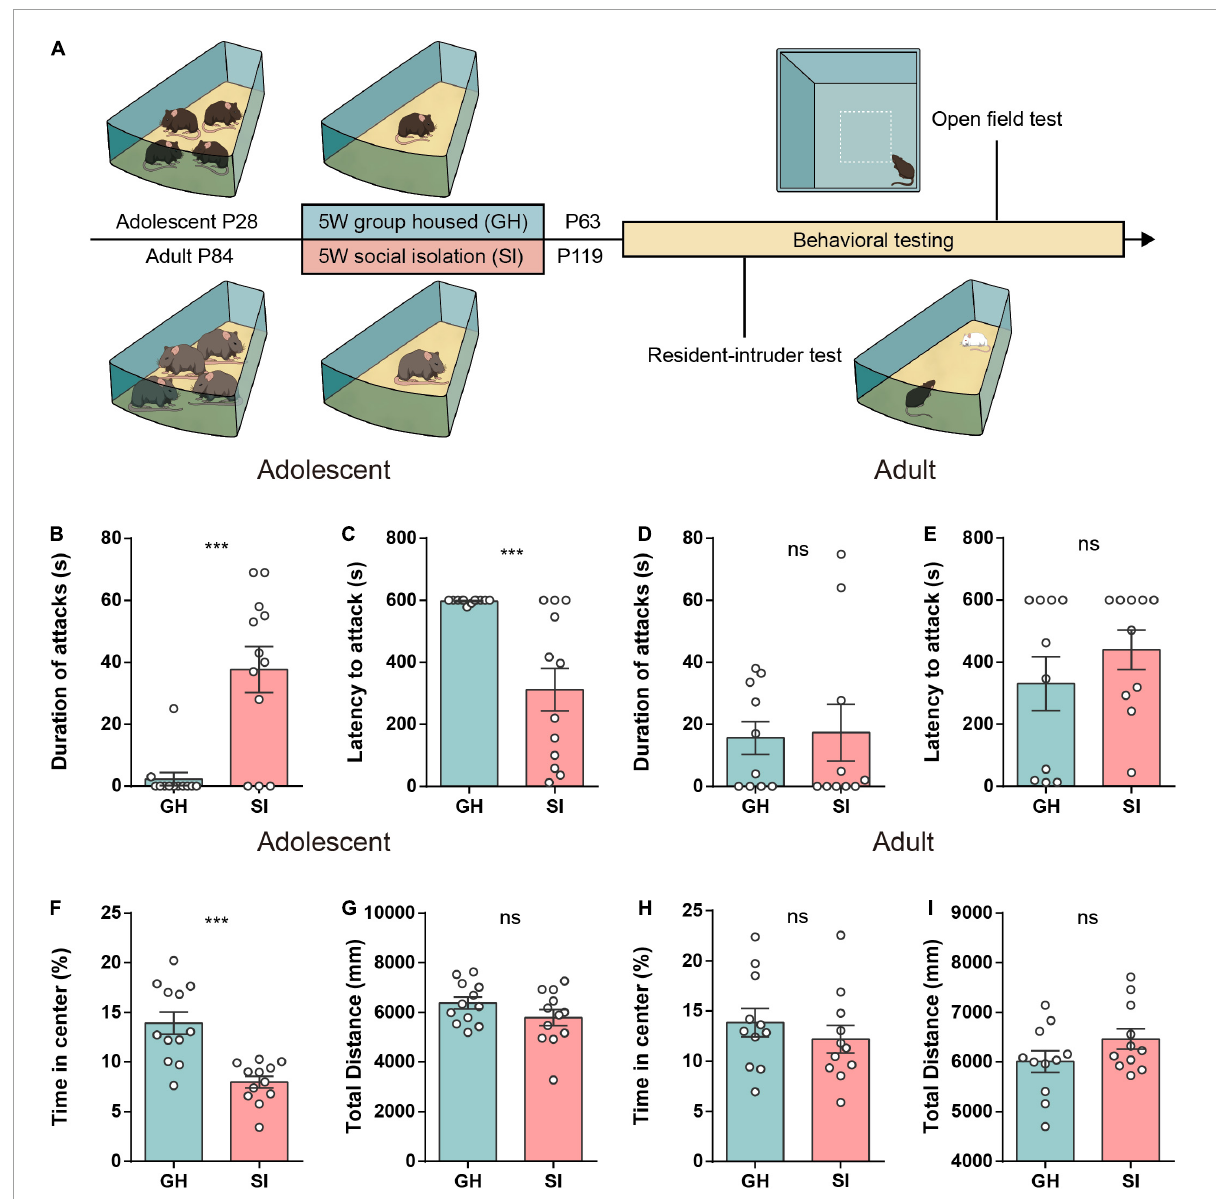
FIGURE1 Mice exposed to chronic isolation stress during adolescence but not adulthood exhibit increased aggression and anxiety-like behavior. (A) Schematic of the social isolation model used in this study. (B,C) The duration (B) and latency (C) of aggression in the RI test of group-housed and socially isolated adolescent mice ( n = 12 mice/group, duration of attack: GH, 2.33 ± 2.08, SI, 37.67 ± 7.44, *** P < 0.001; latency to attack: GH, 597.3 ± 1.94, SI, 311.8 ± 69.10, *** P < 0.001, P values were determined by the two-tailed Mann–Whitney test). (D,E) The duration (D) and latency (E) of aggression in the RI test of group-housed and socially isolated adult mice ( n = 10 mice/group, duration of attack: GH, 15.63 ± 5.28, SI, 17.34 ± 9.12, P = 0.87 determined by a two-tailed unpaired t test; latency to attack: GH, 330.8 ± 87.13, SI, 440.1 ± 63.62, P = 0.41 determined by the two-tailed Mann–Whitney test). (F,G) In the open field test, socially isolated adolescent mice showed a significant decrease in time spent in the central area (F) . The total distance was similar between the two groups (G) ( n = 12 mice/group; time in center, GH, 13.94 ± 1.13, SI, 7.98 ± 0.59, *** P < 0.001; total distance, GH, 6378 ± 239.0, SI, 5789 ± 321.2, P = 0.15 determined by a two-tailed unpaired t test). (H,I) The time spent in the center (H) and the total distance traveled (I) were similar between the two groups of adult mice ( n =